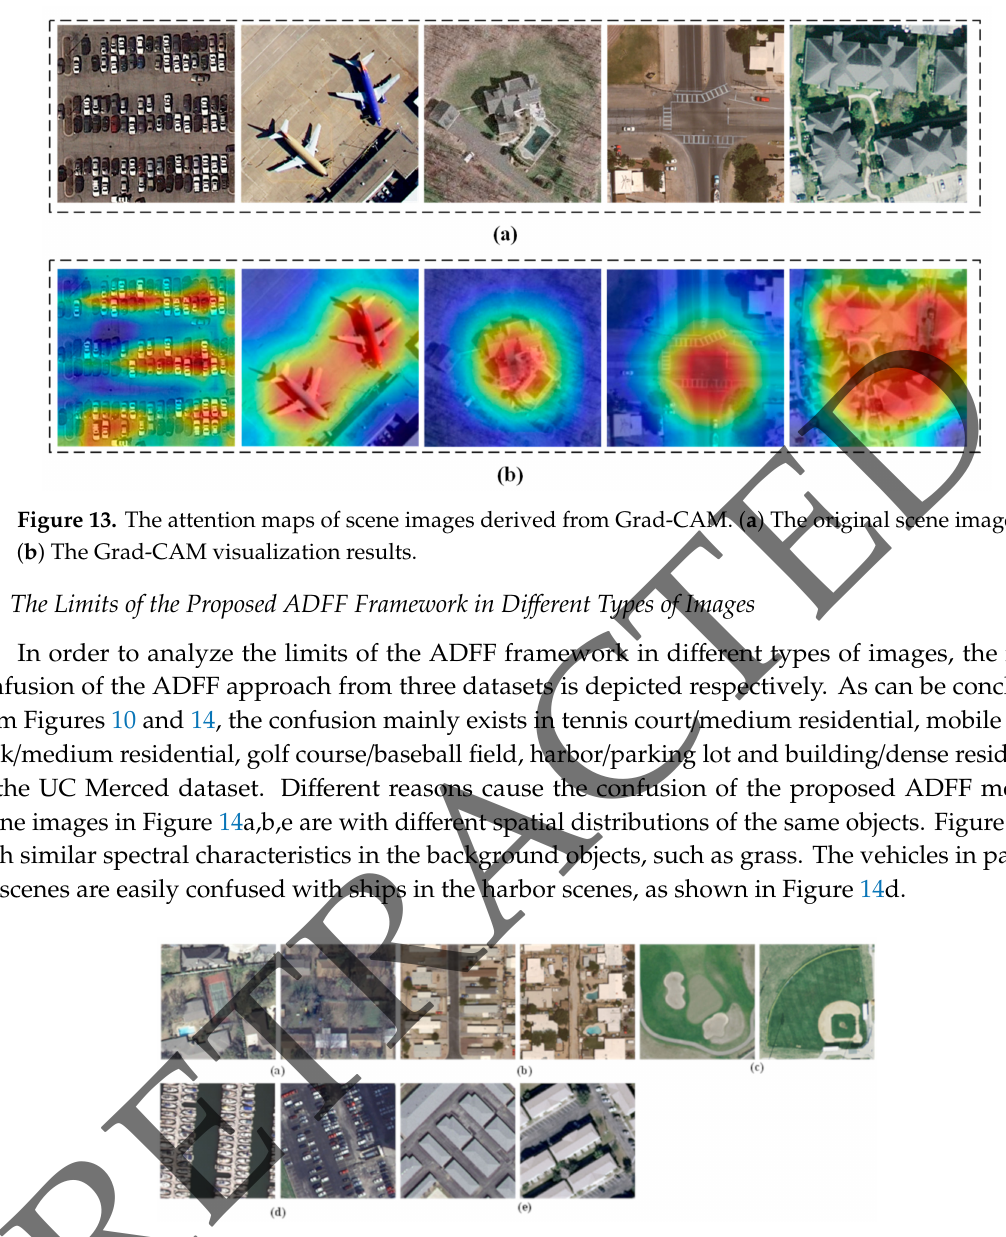
Figure 14. The major confusion of the proposed ADFF approach in the UC Merced dataset. ( a ) Tennis court and medium residential. ( b ) Mobile home park and medium residential. ( c ) Golf course and baseball field. ( d ) Harbor and parking lot. ( e ) Building and dense